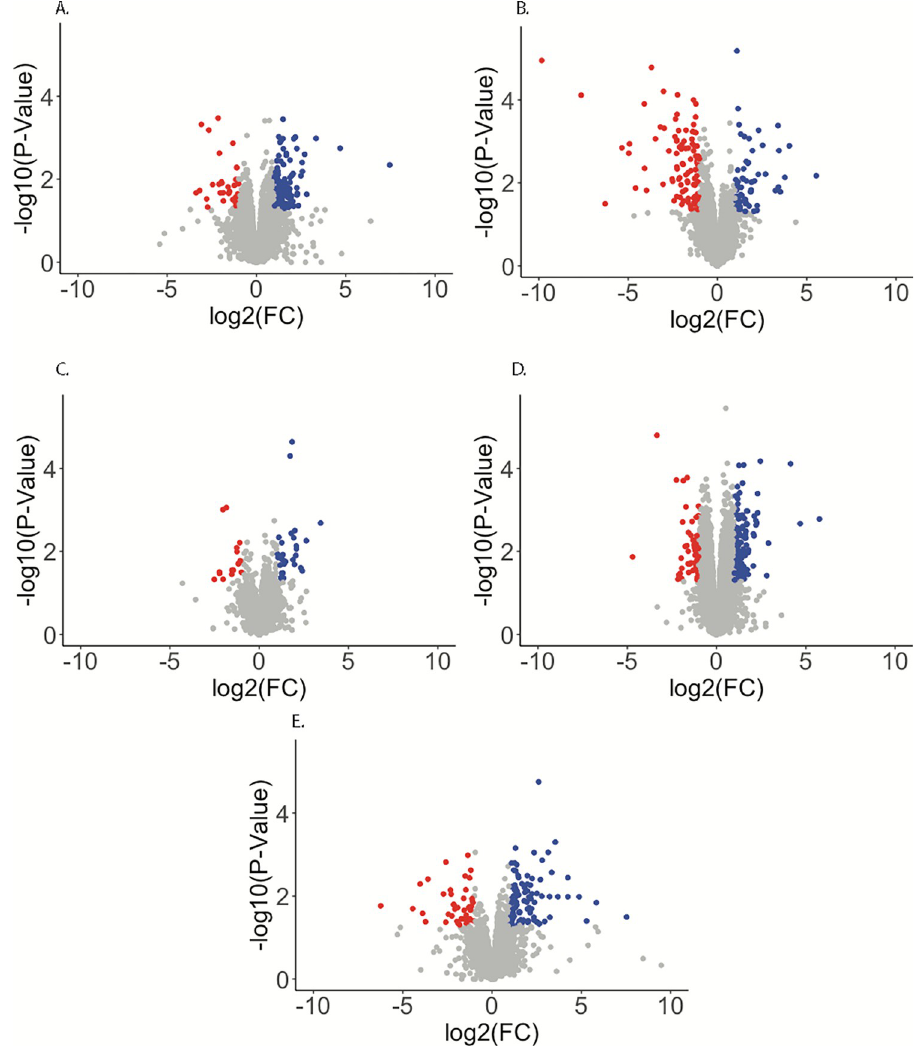
Fig 2. Volcano plots visualizing differential expression of An . stephensi transcripts in response to Mayaro infection. The Y-axis shows -log10 transformed P-values, and the X-axis shows log2 transformed fold change values. Red points represent transcripts depleted by more than -1 log2FC in response to infection with a FDR < 0.05, while blue points are transcripts enriched by more than 1 log2FC in response to infection with a P value < 0.05. A.—C. are transcripts regulated in the 2 dpi, 7 dpi, and 14 dpi groupings respectively, while D. and E. are transcripts regulated in the infected treatment between 2–7 dpi and 7–14 dpi